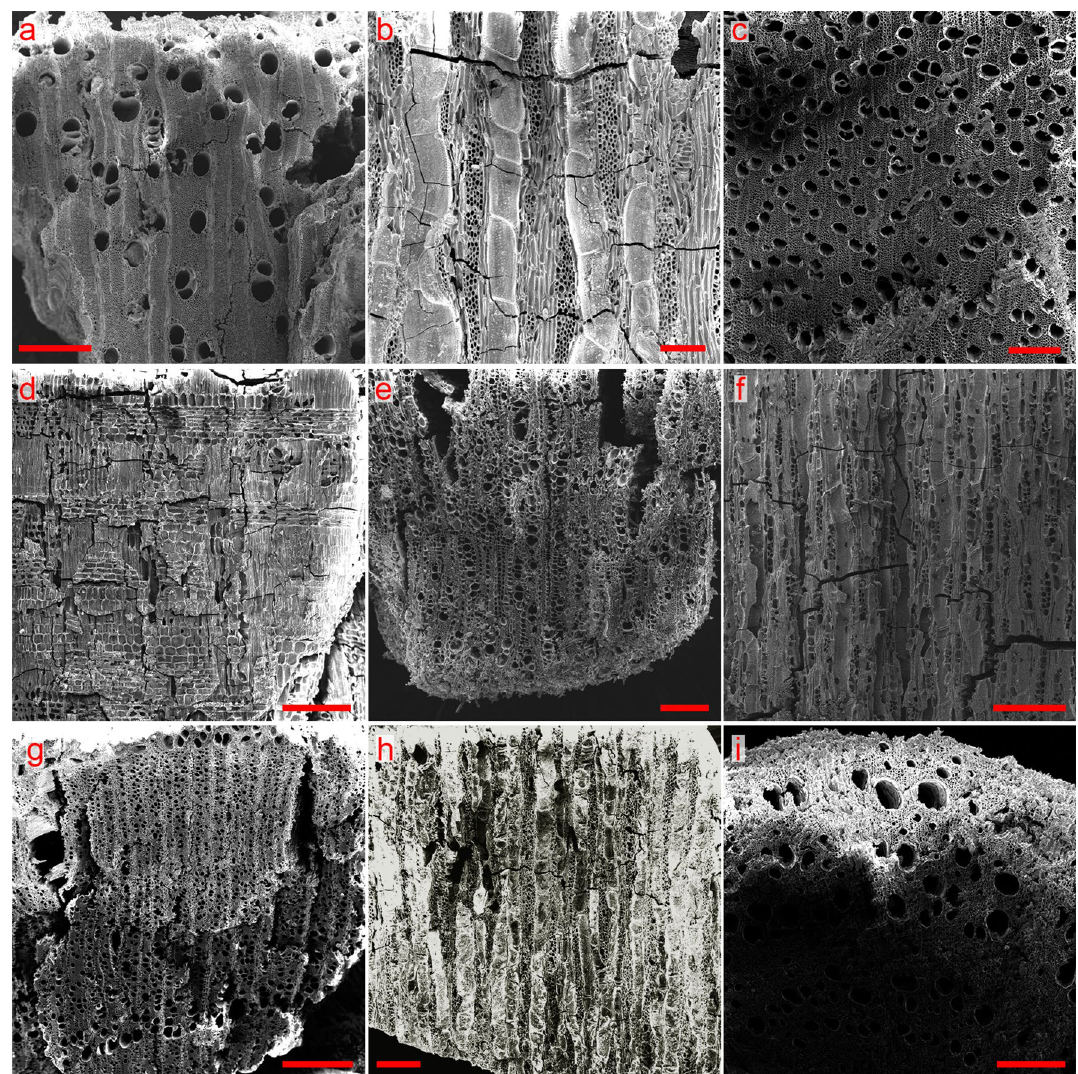
Figure 4. SEM images of charred-wood sections of taxa identified at Tel Tsaf, Area C. ( a ) Ficus carica , transverse, scale 500 μm. ( b ) Ficus carica , tangential, scale 100 μm. ( c ) Salix/Populus , transverse, scale 200 μm. ( d ) Olea europaea , radial, scale 200 μm. ( e ) Olea europaea , transverse, scale 200 μm. ( f ) Olea europaea , tangential, scale 200 μm. ( g ) Cercis siliquastrum , transverse, scale 500 μm. ( h ) Cercis siliquastrum , tangential, scale 200 μm. ( i ) Quercus ithaburensis (twig), transverse, scale 200 μm. Images were taken by M. Cavanagh using a Tescan VEGA3 LMH scanning electron microscope.